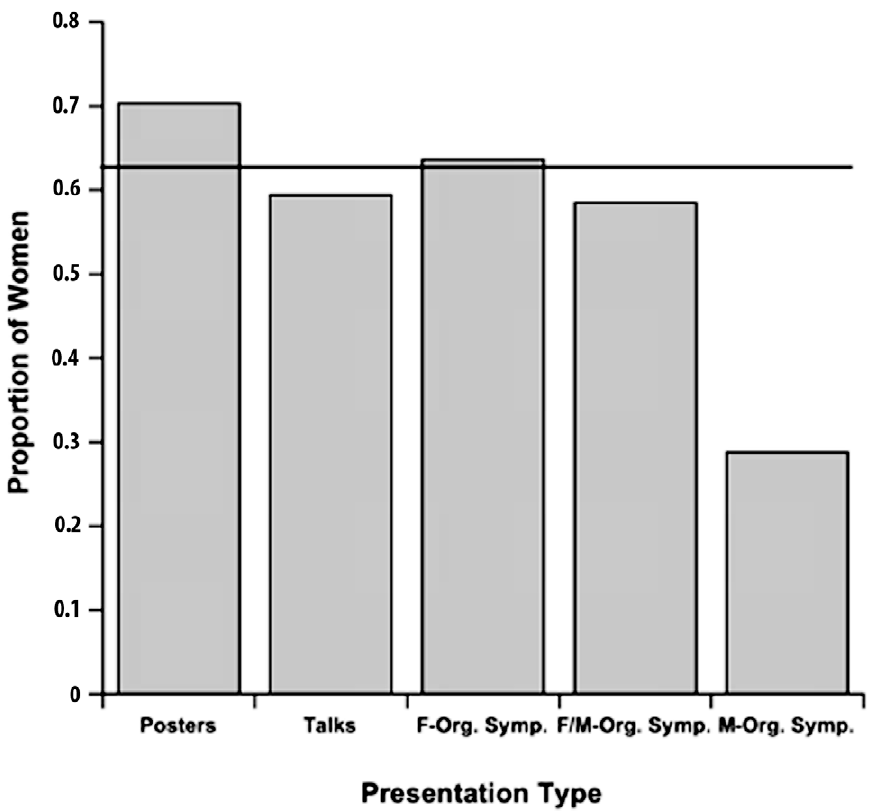
Figure 2. Proportion of women as first authors of posters, talks, and symposia at AAPA meetings. The average proportion for all presentations with women as first authors over a 21-year period of annual meetings of the American Association of Physical Anthropologists is indicated by the solid black line. F-Org. Symp.: symposia organized by women only; F/M Org. Symp.: symposia organized jointly by women and men; M-Org. Symp.: symposia organized by men only.